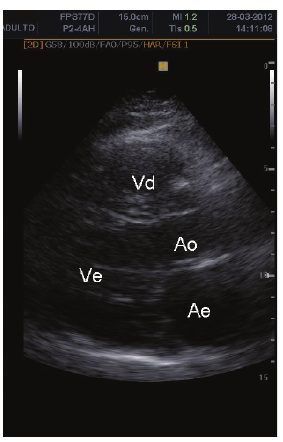
Figure 2: Visualization of the aortic root and aortic valve, both without signs of